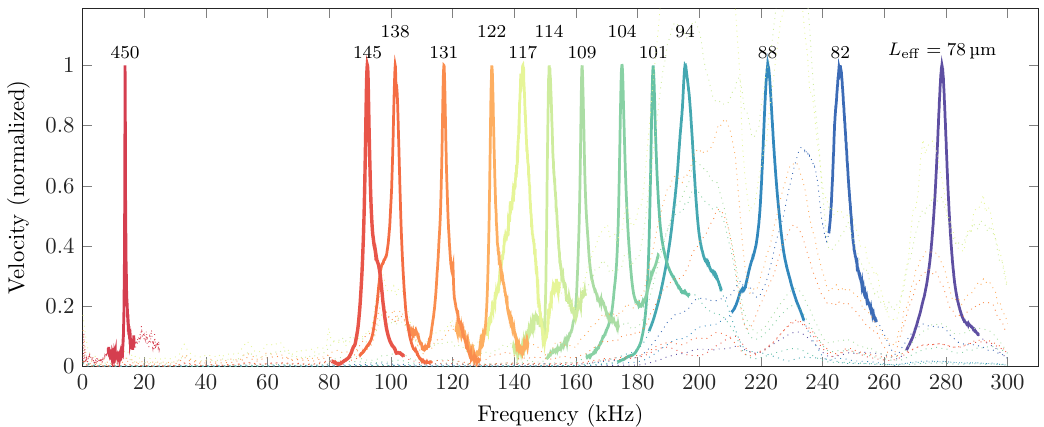
Figure 8. The fundamental resonance frequency obtained for different adjusted lengths of the cantilever. The electrode position is varied and the cantilever is pulled-in for these positions, reducing its effective length. The cantilever is actuated with a frequency sweep and the response is shown in this figure. The numbers above the peaks indicate the effective length of the cantilever (in µm). Only the resonance peaks of the cantilever are shown in a solid line, while the rest of the bandwidth is plotted as a dotted line for clarity. All the measurements were made at an applied voltage of 60 V. More data and a detailed discussion is given in the supplementary material.